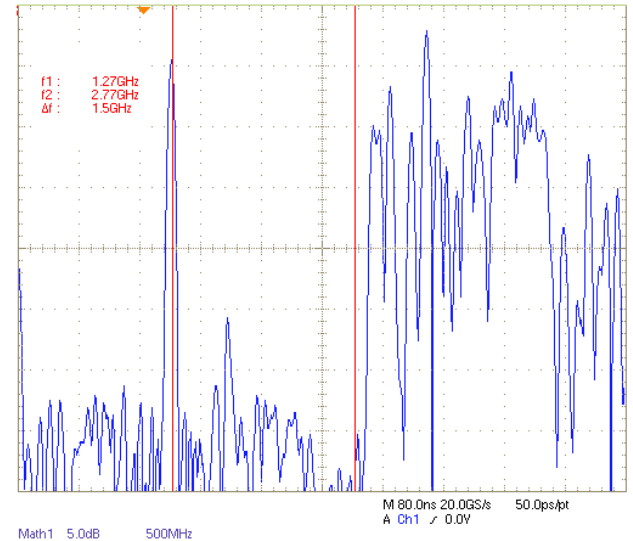
FIG. 7. (Color) Reentrant cavity BPM installed in the FLASH linac.